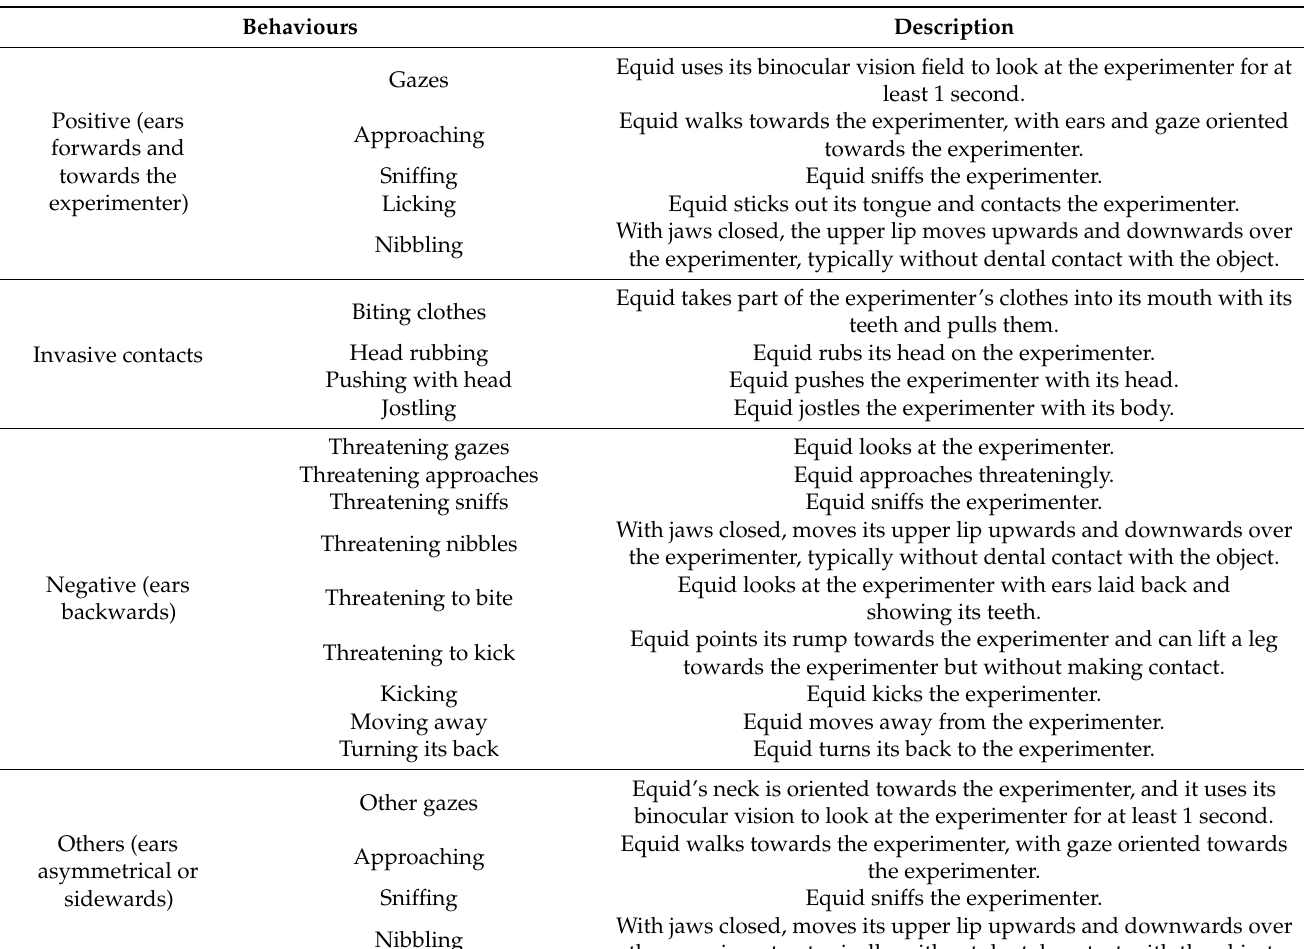
Table 2. List of behaviours recorded during the motionless person test (adapted from Fureix et al. [45]). Behaviours